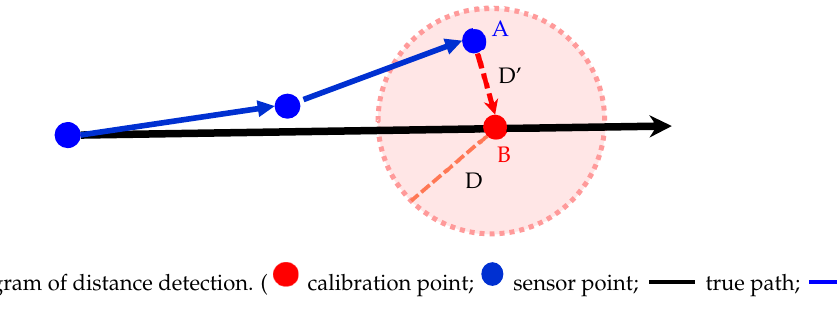
Figure 8. Diagram of distance detection. ( calibration point; sensor point; true path; sensor path.)